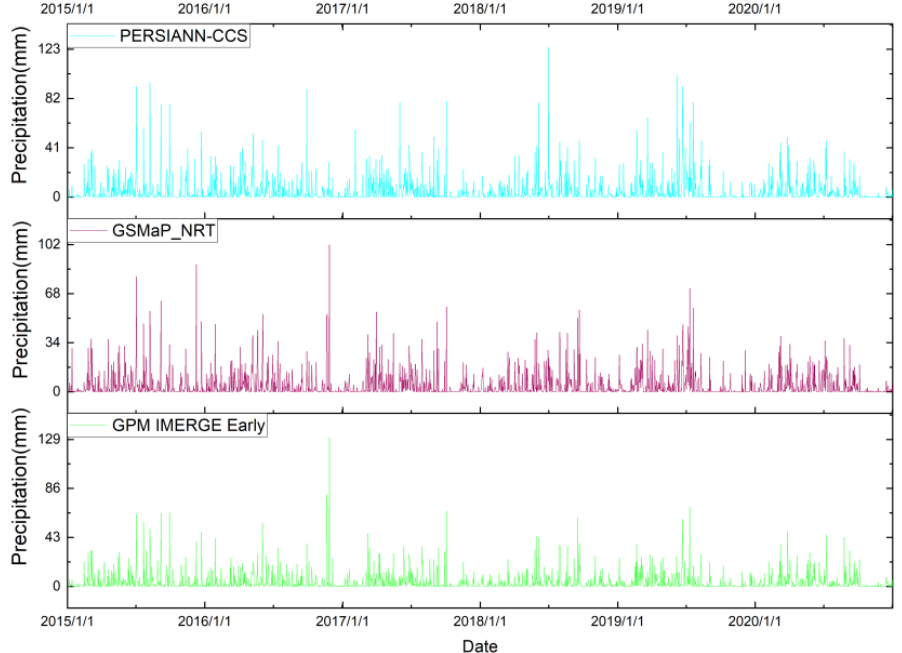
Figure 7. Daily precipitation deviations between three sets of satellite precipitation data and ground-based precipitation data observed at rain gauge station 1.